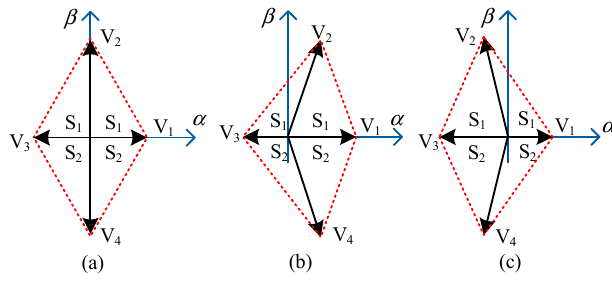
Figure 4. Space vector diagram for 3P4SI. ( a ) V c1 = V c2 ( b ) V c1 < V c2 ( c ) V c1 > V c2.